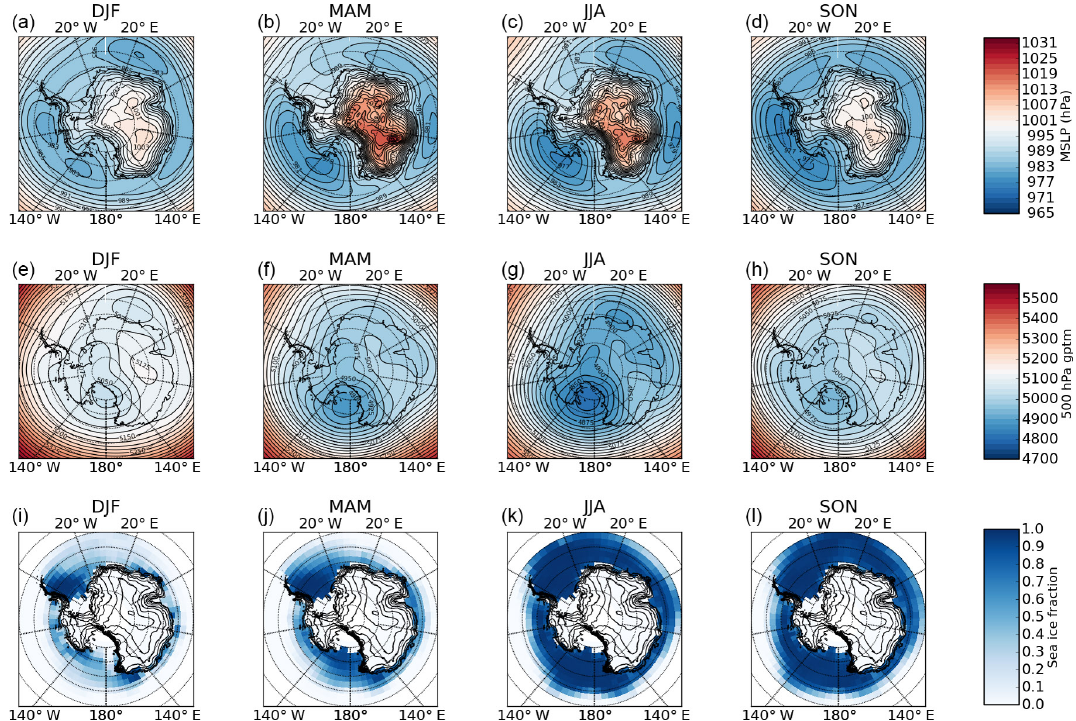
Figure 2. Four-year (2007–2010) seasonal averages of (a–d) the mean sea level pressure (MSLP, in hPa), (e–h) the 500hPa geopotential height (m). Panels (i–l) show the 4-year seasonal average of the sea ice fraction obtained from the National Snow and Ice Data Center and projected onto the grid used to map the cloud fraction (see Sect. 3.2). The topography contours are also